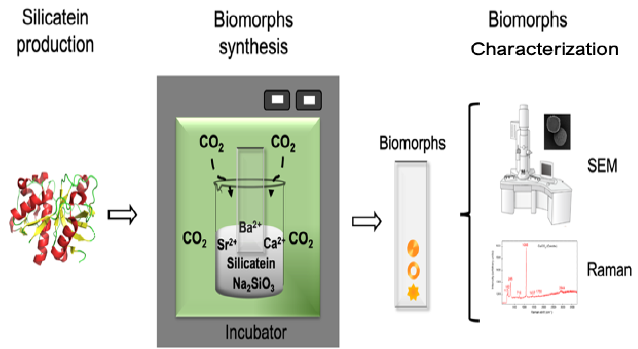
Figure 1. Schematic representation of the procedure involved in the synthesis of silica carbonate biomorphs in solution using a gas-diffusion system. The structure of the T. aurantia silicatein- α corresponds to that deposited in the Protein Data Bank code 6zq3.